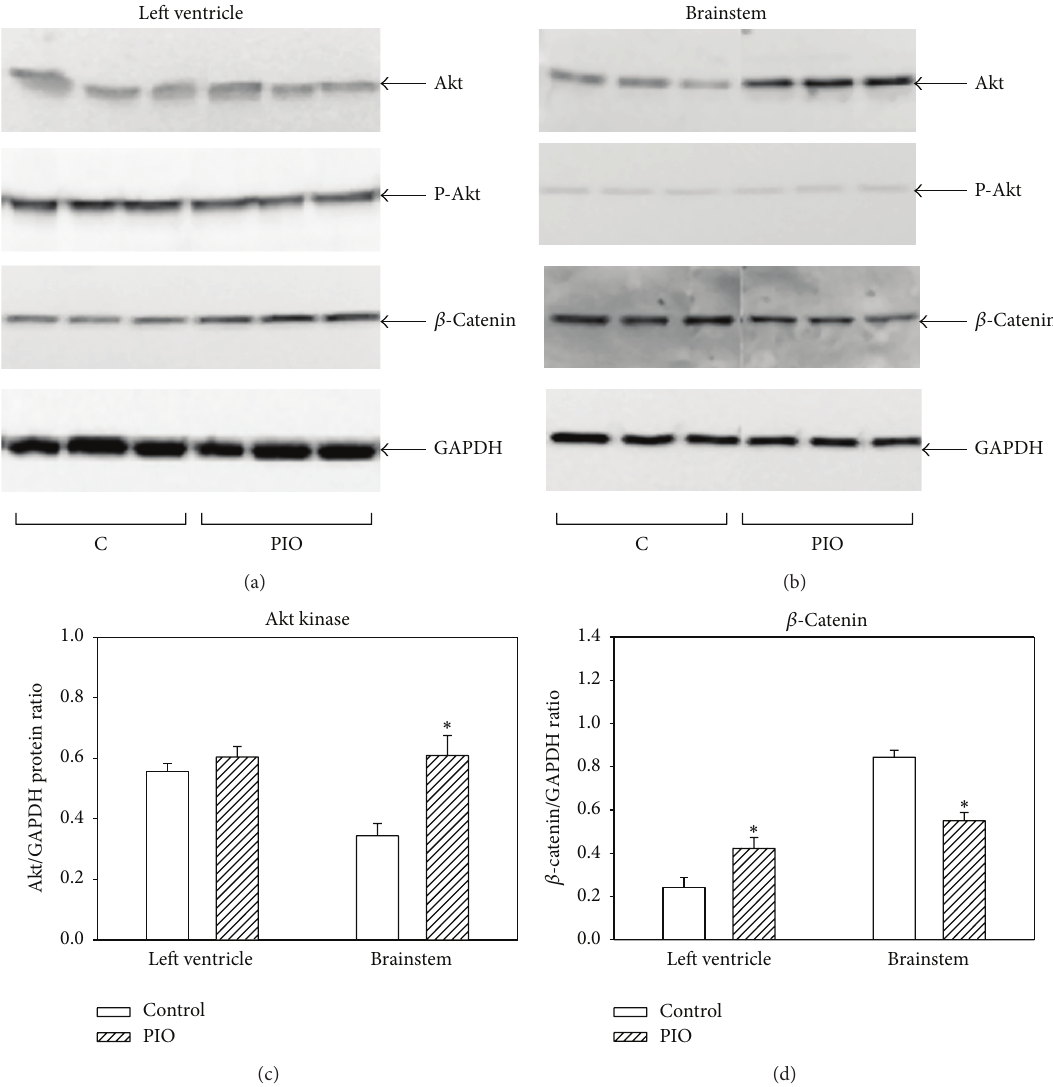
Figure 7: Effect of pioglitazone administration on Akt kinase and 𝛽 -catenin in the left ventricle and brainstem of young SHRs. (a) Western blot records documenting Akt kinase, 𝛽 -catenin and GAPDH protein levels, and levels of Akt kinase phosphorylated specifically at Ser473 (P-Akt) in protein fractions isolated from the tissues of the left ventricle. (b) Western blot records documenting Akt kinase, 𝛽 -catenin and GAPDH protein levels, and P-Akt in brainstem. (c) Quantification of Akt kinase protein levels normalized to the GAPDH protein levels in left ventricle and brainstem. (d) Quantification of 𝛽 -catenin protein levels normalized to the GAPDH protein levels in left ventricle and brainstem. Data were obtained from Western blot records and each bar represents mean ± SEM, of 7 tissue samples per group. ∗ 𝑃 < 0.05 , PIO versus